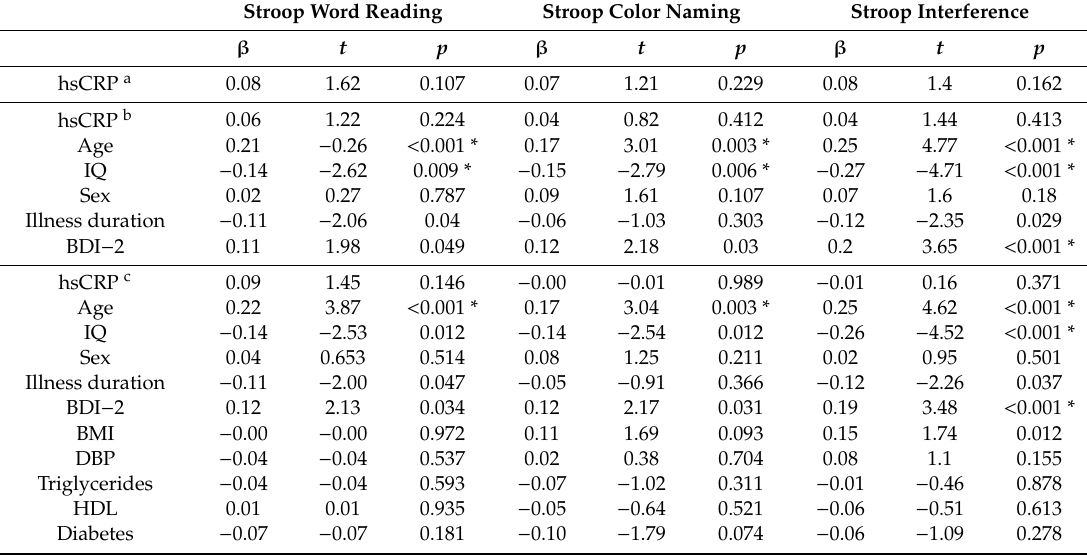
Table 4. The association of serum hsCRP concentration with Stroop Test performance as a function of age, verbal IQ ( N =